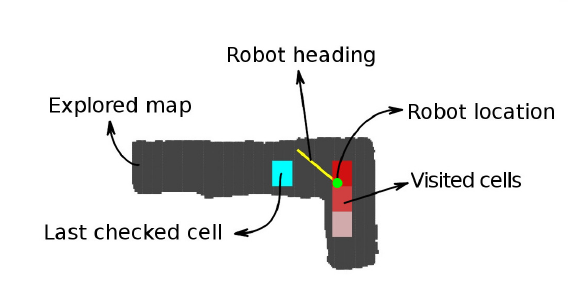
Figure 12. Interpretation of map diagrams.